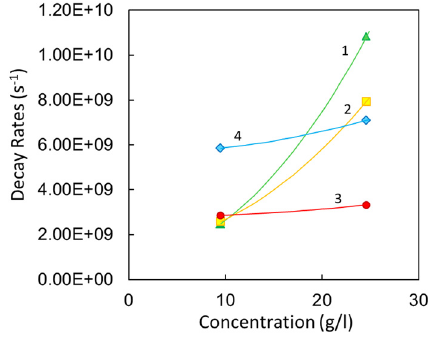
Figure 6: Emission decay rates for HITC:PMMA films at two different dye concentrations, n = 9.5 g/l and n = 24.6 g/l, on top of the glass (trace 1, green triangles), smooth Ag fi lms (trace 2, yellow squares), and arrays of Ag nanowires: Upper boundary of the kinetics spread (trace3,redcircles)andlowerboundaryofthekineticsspread(trace4, blue diamonds). The solid lines were calculated using the determined parameters A + W and γ .